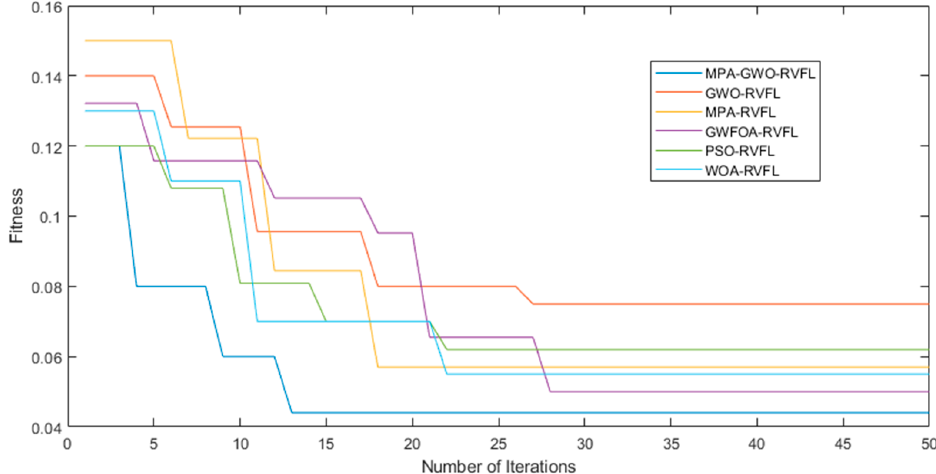
Figure 7. Iterative convergence curve.